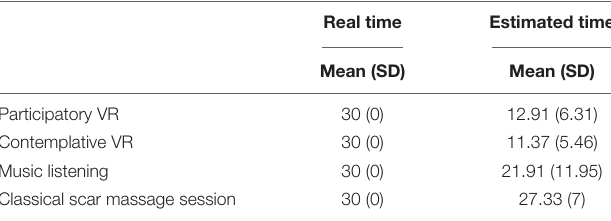
TABLE 3 | Means and standard deviation of time (real vs. estimated) by experimental